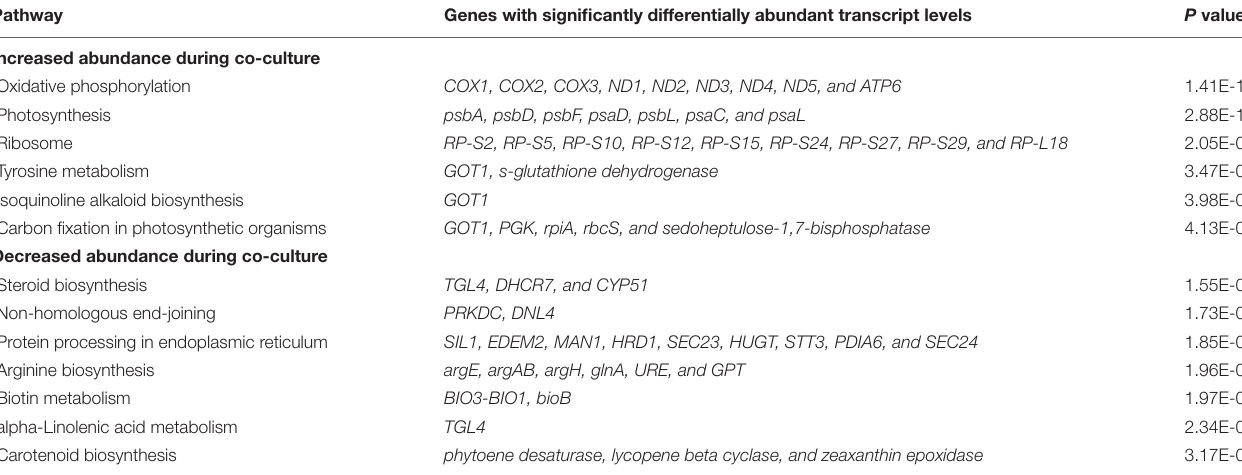
TABLE 1 | Isochrysis galbana pathways and selected KEGG categories significantly enriched or depleted in co-culture. Pathway Genes with significantly differentially abundant transcript levels P